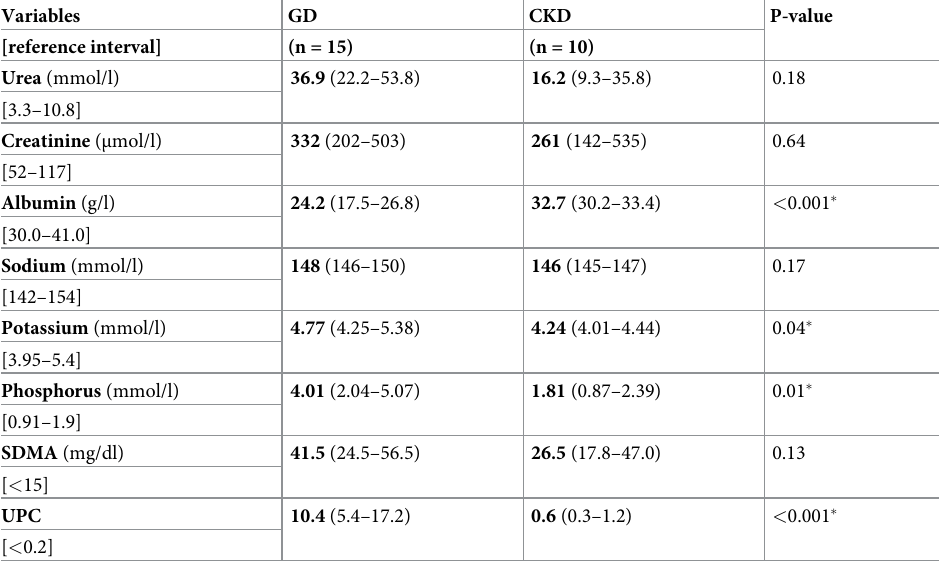
Table 2. General laboratory variables of 15 dogs with glomerular disease (GD) and 10 dogs with chronic kidney disease (CKD) included in the study. Variables GD CKD